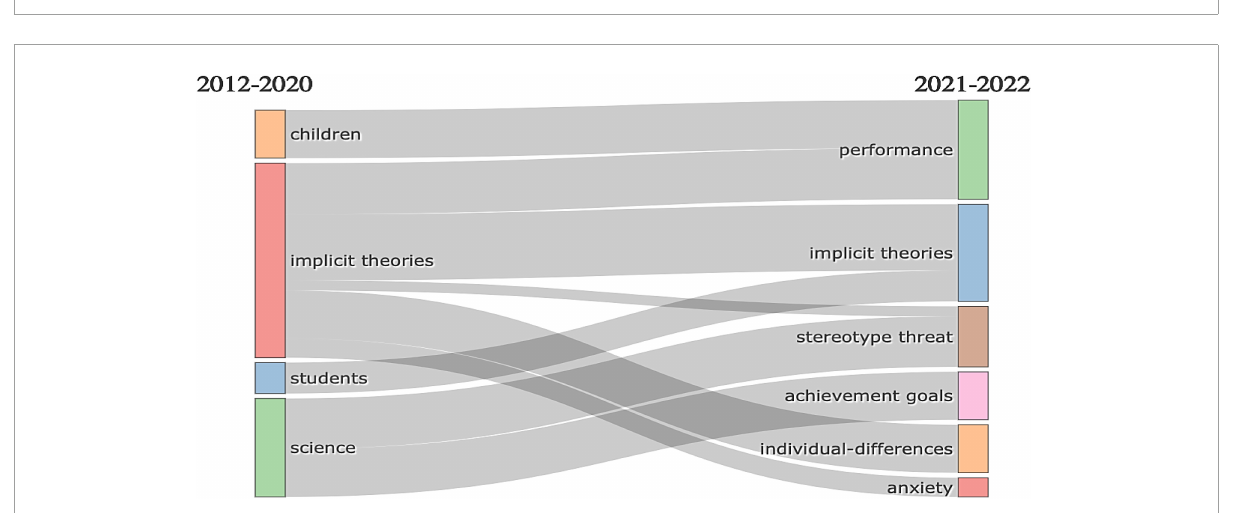
FIGURE9 Bubble chart mapping thematic networks.